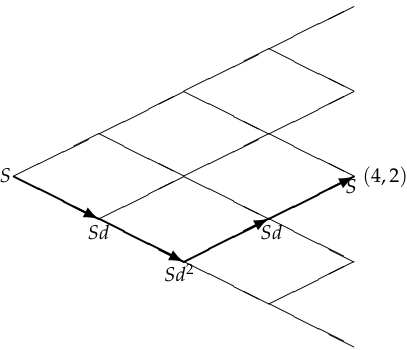
Figure 3. Trajectory τ min ( 4,2 ) for node ( 4,2 ) of the tree discretizing the asset value in regime